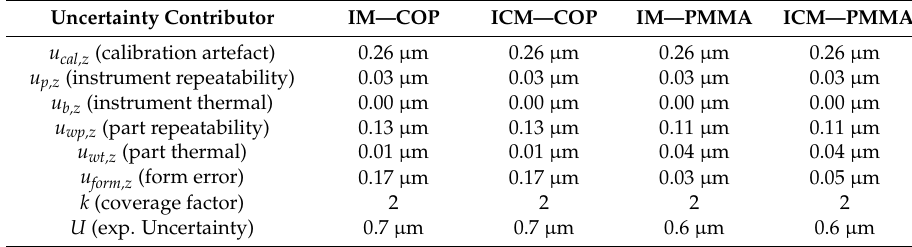
Table 3. Pitch measurements’ uncertainty budget for COP and PMMA in IM and ICM, of a nominal grooves’ width of 748.1 µm. Measurements are calibrated with a gauge block thickness of 1500 µm.